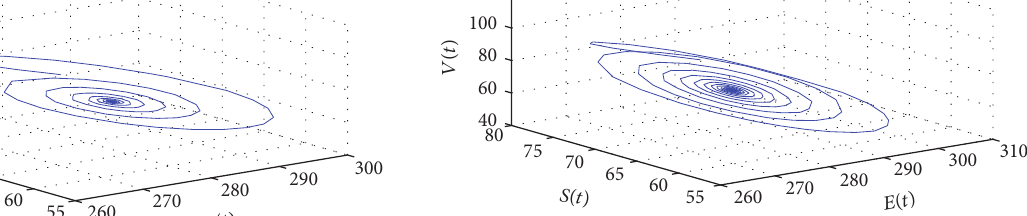
Figure 9: The projection of the phase portrait of system (69) in (𝑆,𝐸, 𝑉) -space with 𝜏